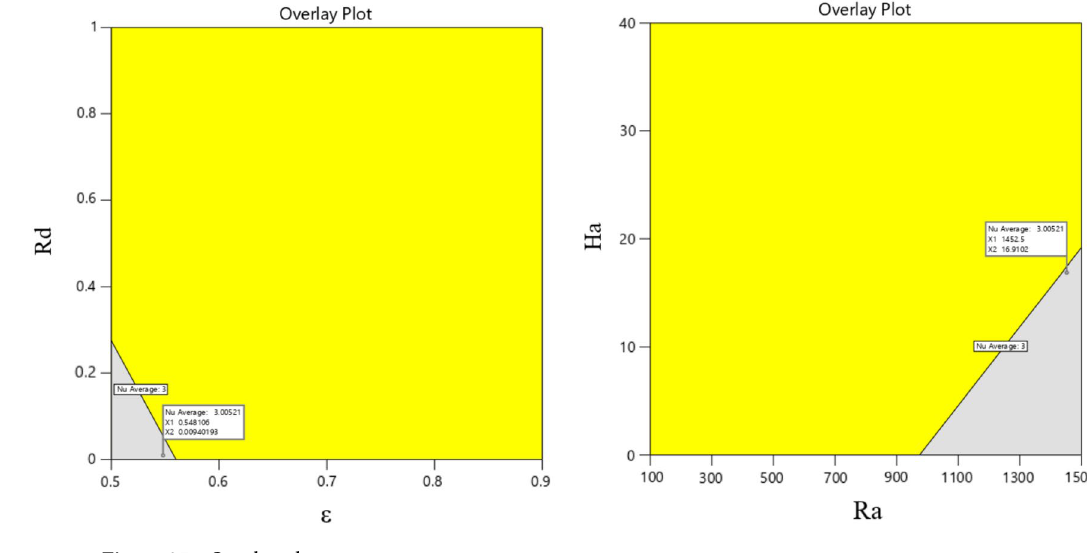
Figure 25. Overlay plots.